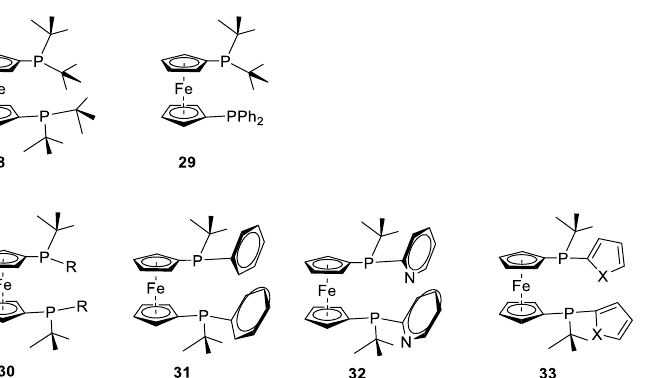
Figure 23. A small selection of the ferrocene-based ligands used in methoxycarbonylation, from the ligands developed by Cullen et al. ( 28 : T-J. Kim; 29 : Butler), 30 , general ligand design; and 31 , 32 , 33 , ligands developed by Beller et